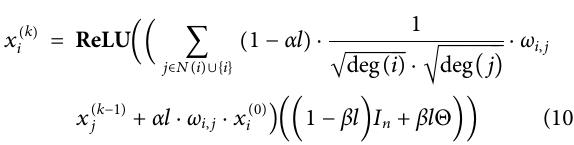
Frontiers in Energy Research |